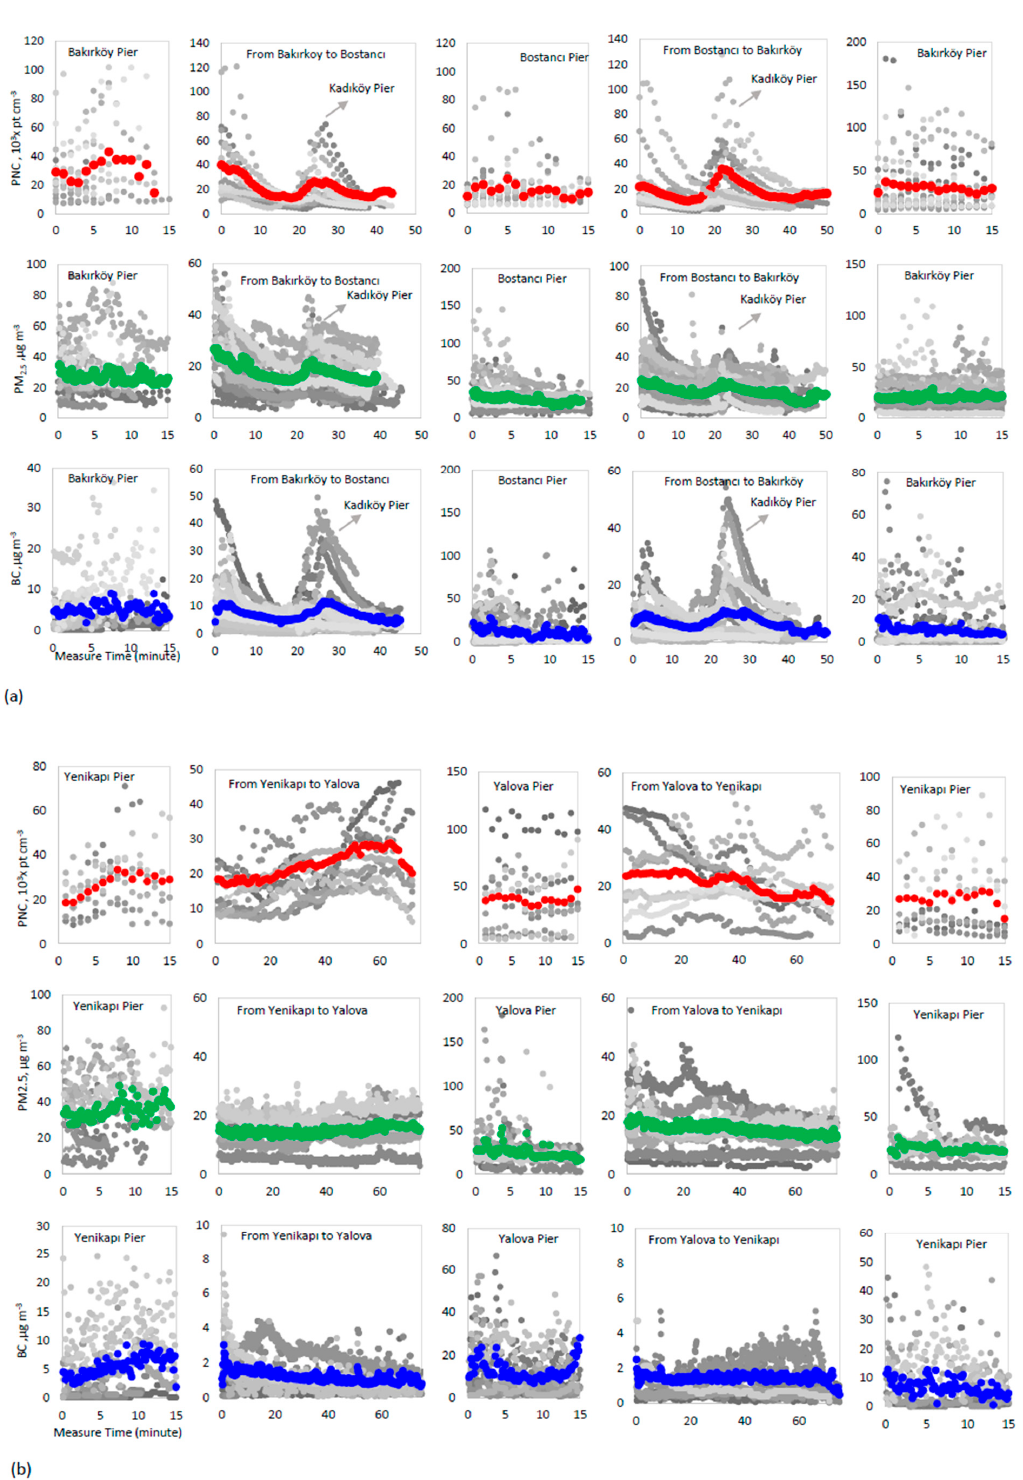
Figure 3. Time series of the concentrations of black carbon (BC), PM 2.5 , and particle number concentration (PNC) during trips for ( a ) fast ferry and ( b ) car ferry. The mean concentrations of all trips are illustrated with a red line for PNC, a green line for PM 2.5 and a blue line for BC. *The gray dots show all of the measurements. The graphs from left to right in Figure 3a show Bakırköy pier, in fast ferry from Bakırköy to Bostancı, Bostancı pier, in fast ferry from Bostancı to Bakırköy, and Bakırköy pier, respectively. The graphs from left to right in Figure 3b show Yenikapı pier, in car ferry